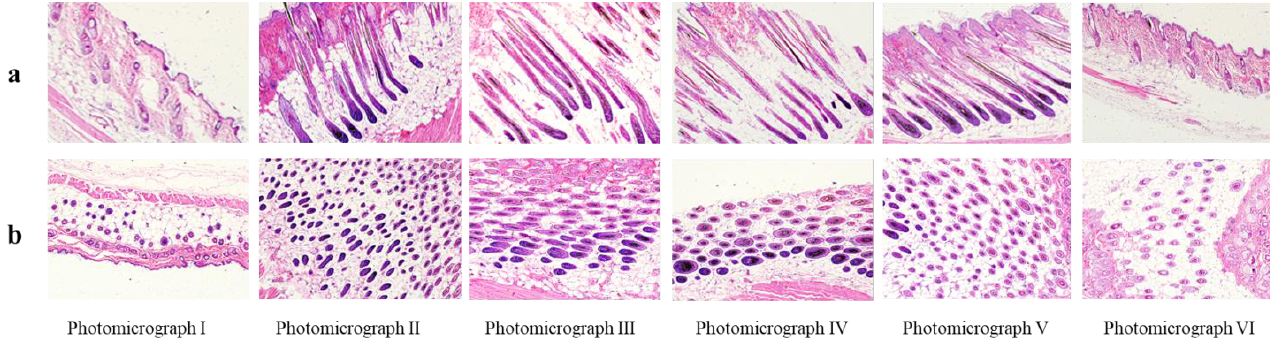
Figure 7. Effects of topical CE-NE, 2% minoxidil and ointment on hair follicles in C57BL/6 mice. Photographs for different groups in mice ( a ) and vertical section ( b ) horizontal section. Photomicrograph I: hair follicles in blank control group; Photomicrograph II: hair follicles in CE-NE (25 mg/mL) group; Photomicrograph III: hair follicles in CE-NE (50 mg/mL) group; Photomicrograph IV: hair follicles in ointment group; Photomicrograph V: hair follicles in 2% minoxidil group; VI: hair follicles in CE-NE (100 mg/ mL) group. ( n = 6).